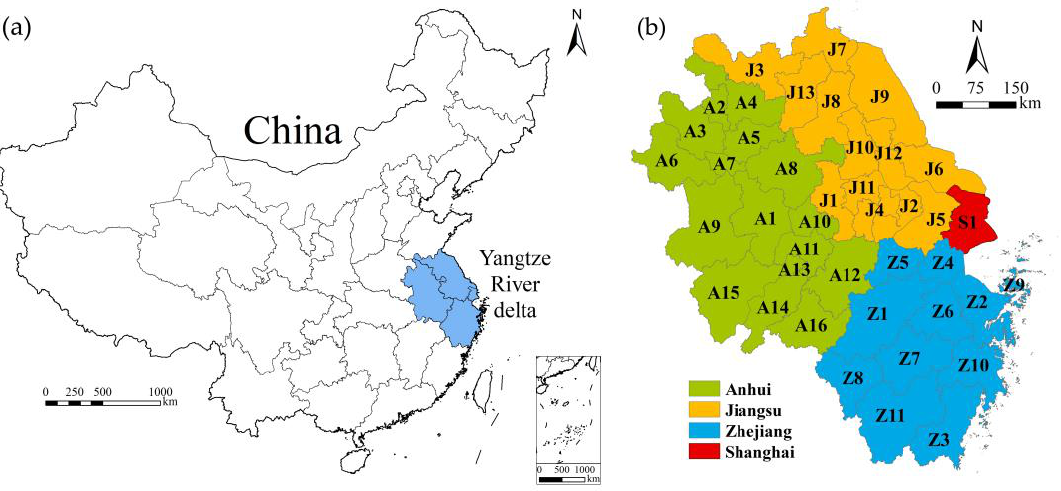
Figure 1. ( a ) Location of the YRD region in China. ( b ) Location of different provinces and cities in the YRD region. Note: This map is based on the standard map (Drawing review No.: GS (2019)1822). Table 1. City codes in the YRD region.